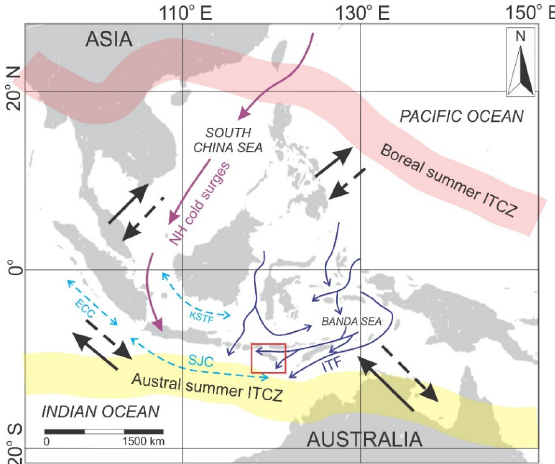
Figure 1. Modern climate and oceanographic features of Indonesia, compiled from previous studies [8,41,42,46–48,50,55]. Black arrows: dominant wind direction during AIWM (solid) and AISM (dashed). Light blue dashed two-way arrows: wind-driven surface currents (i.e., ECC, SJC, and KSTF). Dark blue arrows: ITF. Purple arrows: NH cold surges. Red shading: boreal summer ITCZ. Yellow shading: austral summer ITCZ. The red rectangle indicates the Sumba